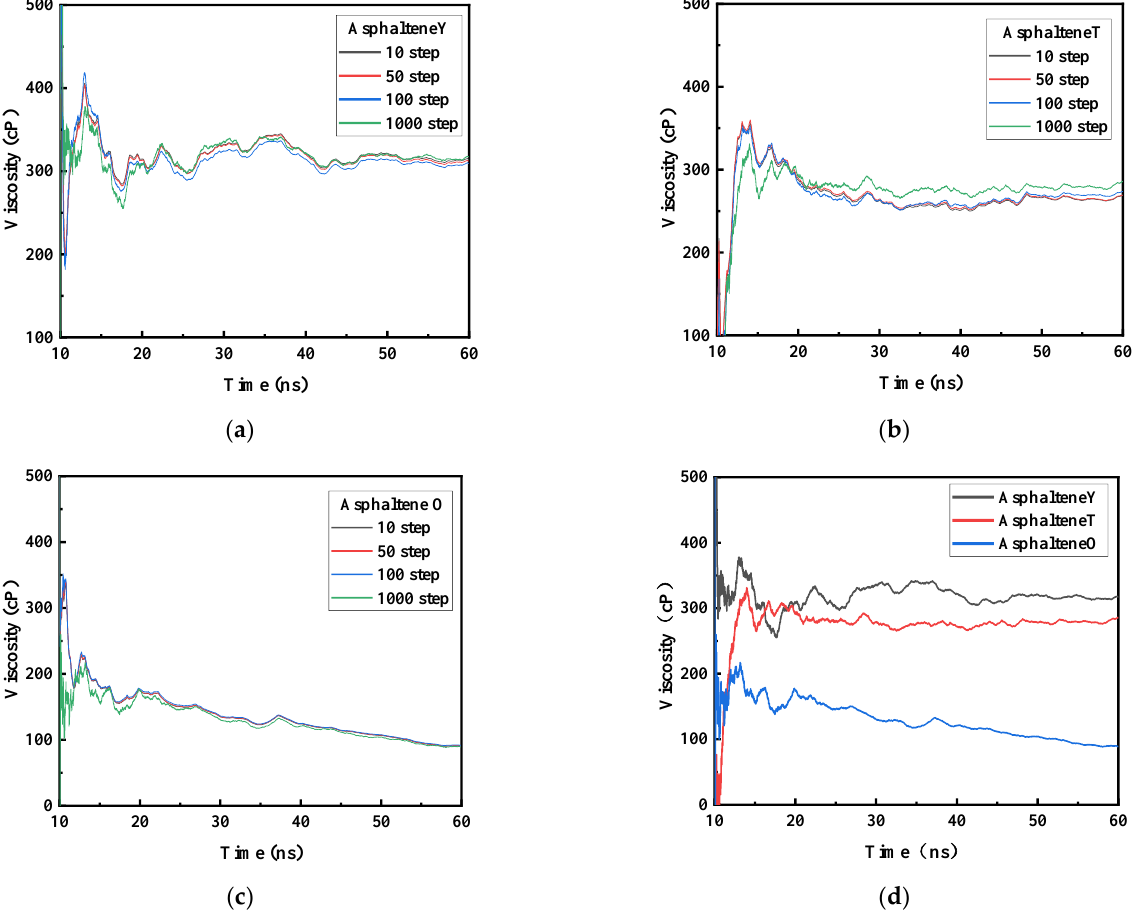
Figure 3. Viscosity change diagrams of three kinds of asphaltene molecules during the NEMD simulations process. ( a ) AsphalteneY, ( b ) AsphalteneT, ( c ) AsphalteneO, and ( d ) AsphalteneY, AsphalteneT and AsphalteneO.